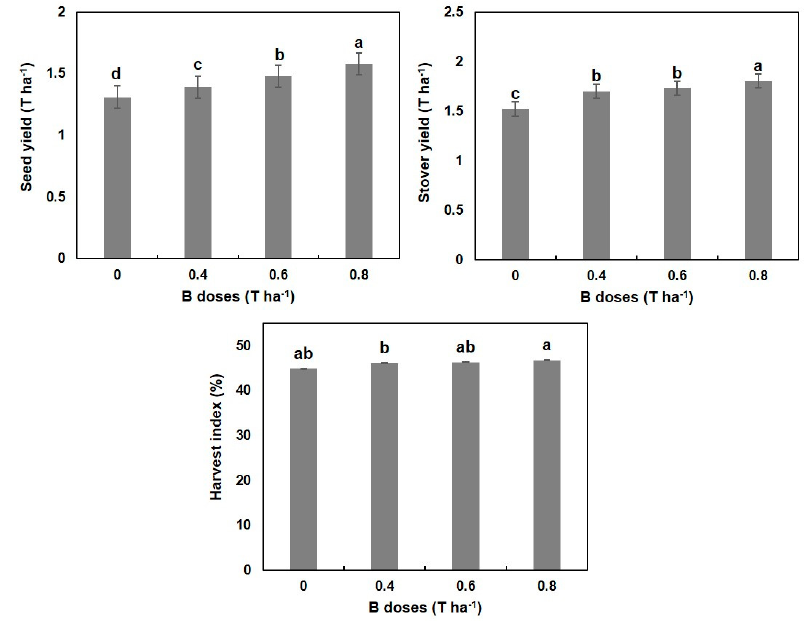
Figure 4. B’s impact on Seed and Stover Yield and Harvest Index of Mustard. Figures with same letter (s) do not differ significantly, whereas figures with dissimilar letters differ significantly as per